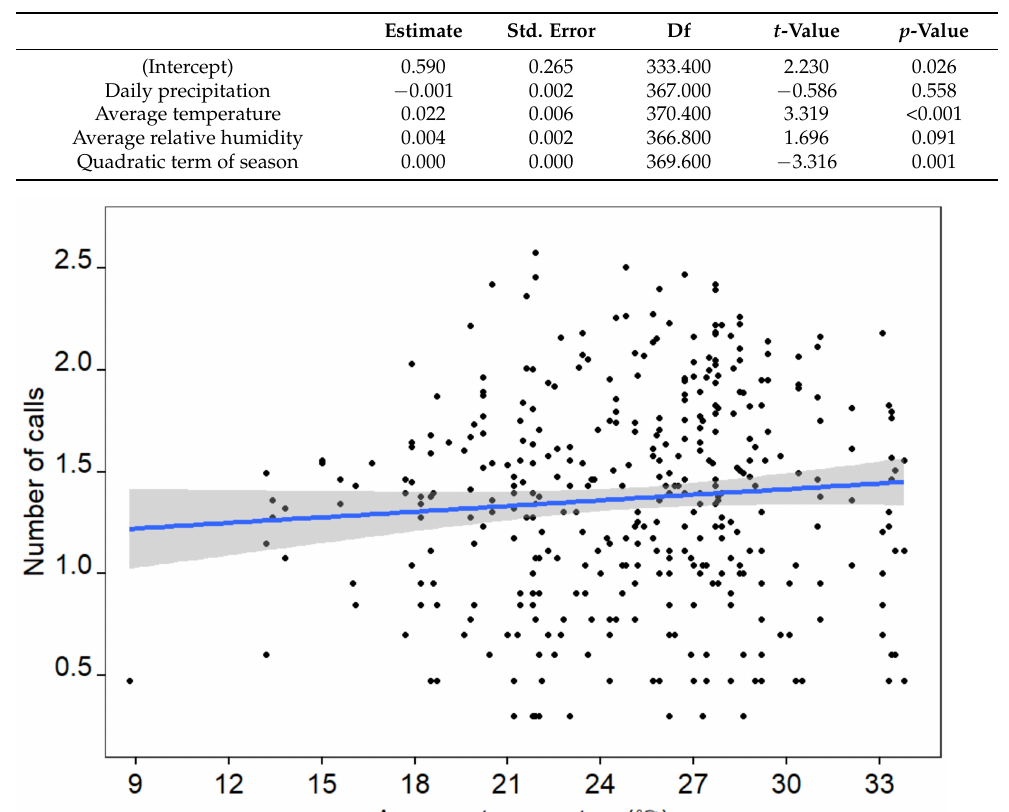
Table 2. Results of the LMM analyzing the effects of weather parameters on the daily vocal activity of the Oriental Turtle Dove in the YNNR.